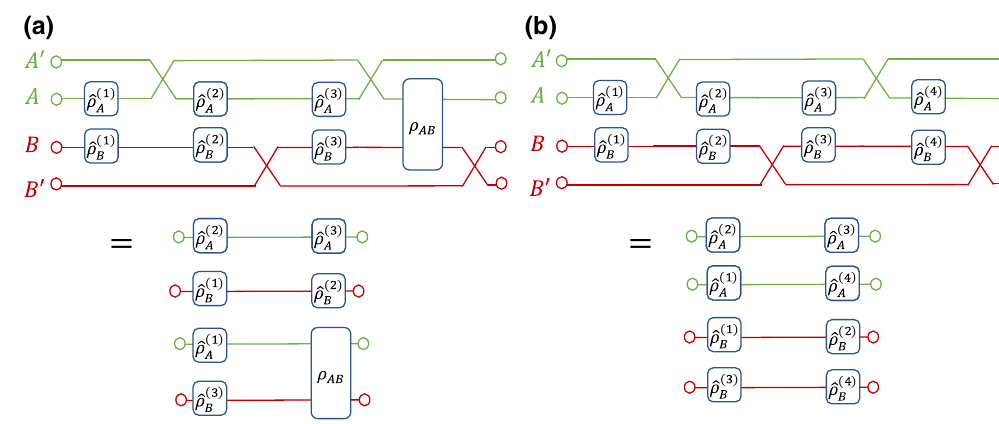
FIG. 9. Tensor diagrams for the case k = 3. (a) A graphical representation for the term in Eq. (C66). (b) A representation for the term for k = 4 shadows as in Eq.